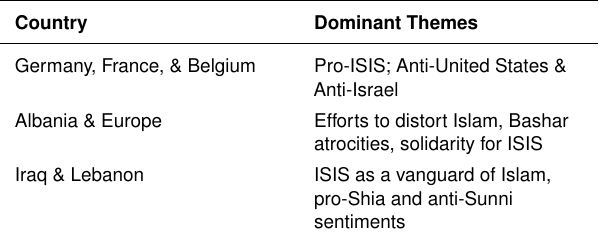
Table 8. Sample dominant themes by